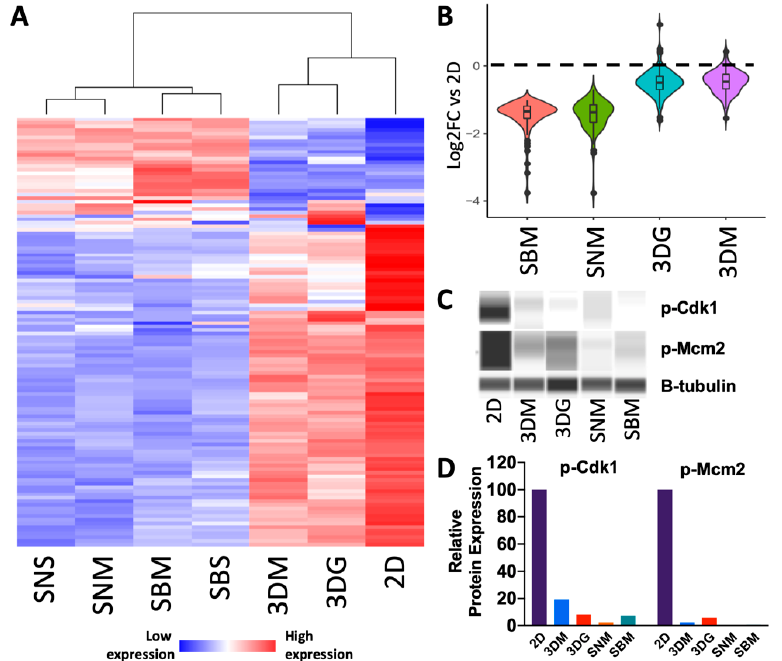
Figure 3. Cell cycle progression genes are up-regulated in cells cultured in monolayer culture. ( A ) Heat map of differentially expressed cell cycle genes (Supplementary Table S4) relative to 2D culture depicting increased down-regulation as culturing complexity increases (n = 4–5). ( B ) Violin plot depicting magnitude of down-regulation and distribution of SBM vs. 2D up-regulated cell cycle progression genes across other culturing conditions relative to 2D culture. ( C ) Pseudogel representation of protein levels of phosphorylated cell cycle genes (Cdk1 and Mcm2) from 4T1 cells cultured across multiple conditions. ( D ) Quantification of protein levels relative to β -tubulin. Structuring and remodeling of the tumor ECM and surrounding tissue is an essential facet of tumor initiation, extravasation and intravasation that allow the disease to progress [18]. The 4T1 cells